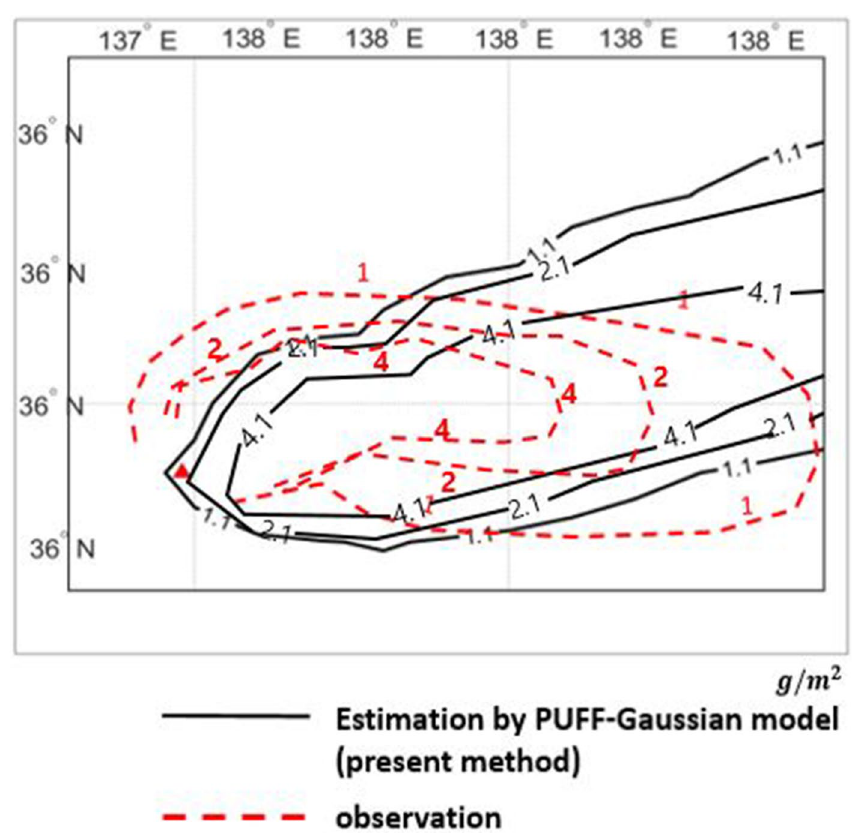
Figure 15. Comparison of ash deposition from the Ontake volcano eruption from September 27, 2014 between observations and the PUFF–Gaussian model estimation for 1 g / m 2 , 2 g / m 2 , 4 g / m